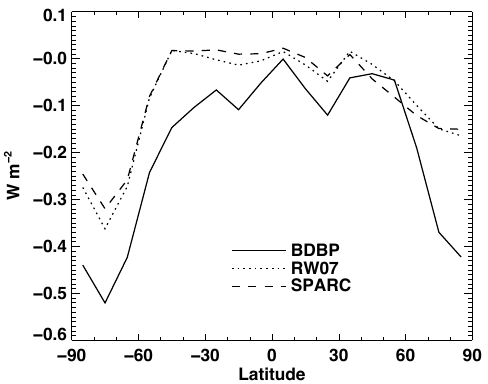
Fig. 9. Annual mean radiative forcing due to ozone changes be- Figure 9. Annual mean radiative forcing due to ozone changes between 1979-1981 and 1995-2 tween 1979–1981 and 1995–1997 averages for BDBP (solid line), 1997 averages for BDBP (solid line), RW07 (dotted line), and SPARC (dashed line) ozone 3 RW07 (dotted line), and SPARC (dashed line) ozone data sets. The databases. The global mean values from these calculations are given in Table 3 (column 4 global mean values from these calculations are given in Table 3 (col- total). 5 umn